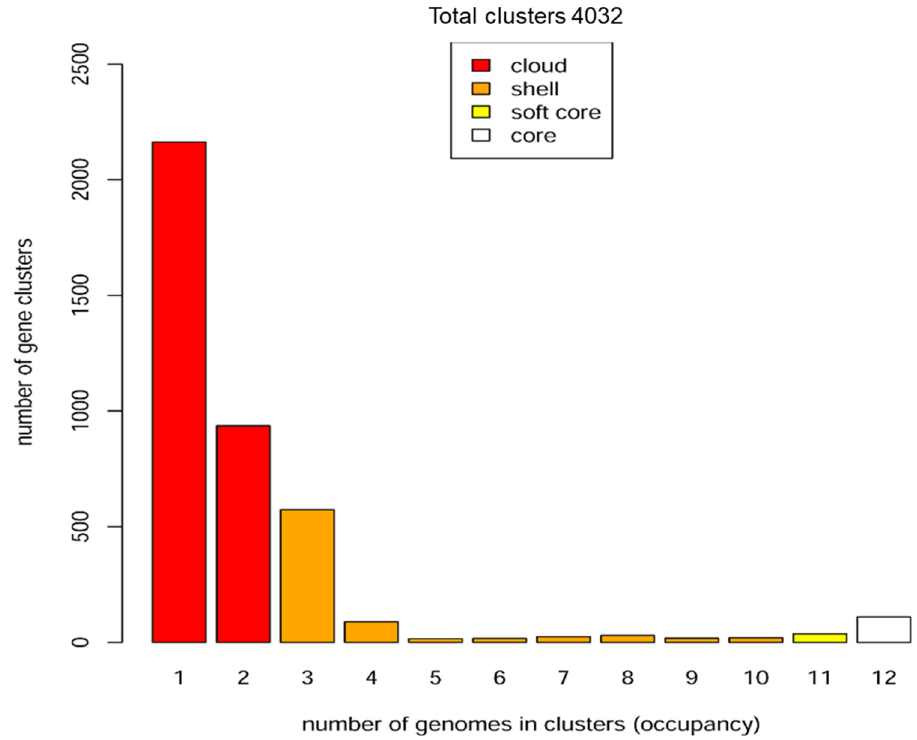
Figure 3. Pan-genome distribution in four categories (cloud, shell, soft core, and core) of 12 hemoplasmas. The core, softcore, shell, and cloud genomes are composed 110, 146, 787, and 3099 gene clusters, respectively.